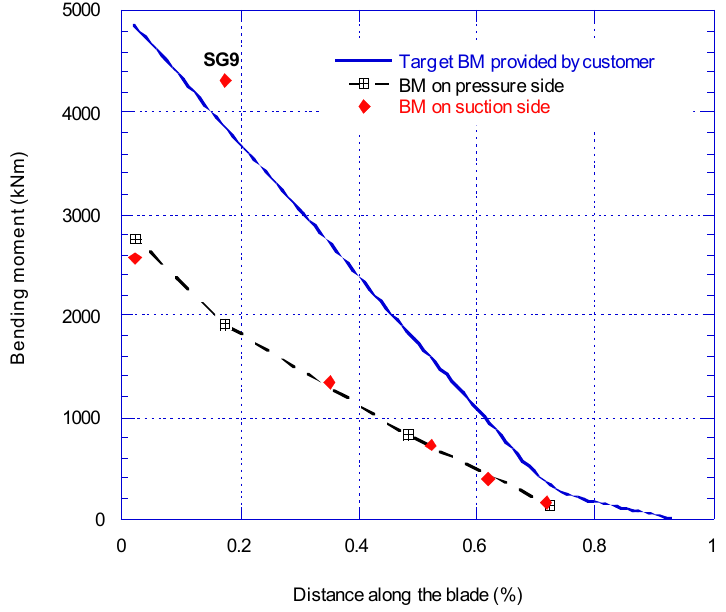
Figure 5. Comparison of target and applied bending moment distribution for as received blade.